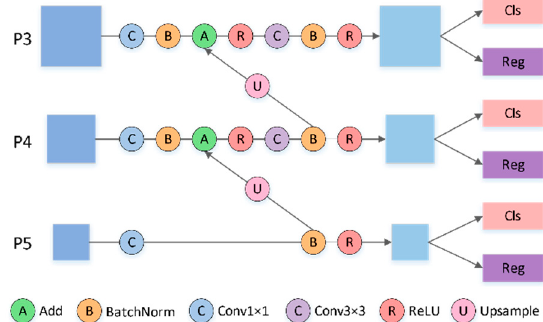
Figure 1. Architecture of the proposed rotation-decoupled detector. The darker blue squares represent the feature maps with different scales from the backbone network, the lighter blue squares are the feature maps with different scales after fusion, the circle represents an operation, and the arrows indicate the order of operations.